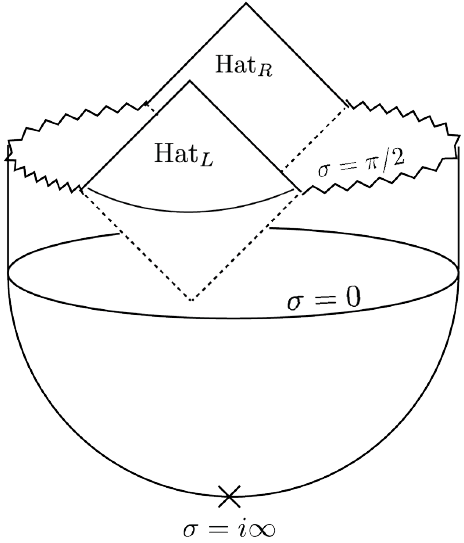
Figure 7. The connected, two-hat saddle which we are interested in studying. Here we have illustrated the Lorentzian to Euclidean continuation of this saddle from the σ = 0 line. This is a hemisphere of curvature R = 2 but with a conical excess at σ = i ∞ , the south pole of the hemisphere. The conical singularity has an opening angle of 4 πn . For n hats, it would have an opening angle of 2 πn